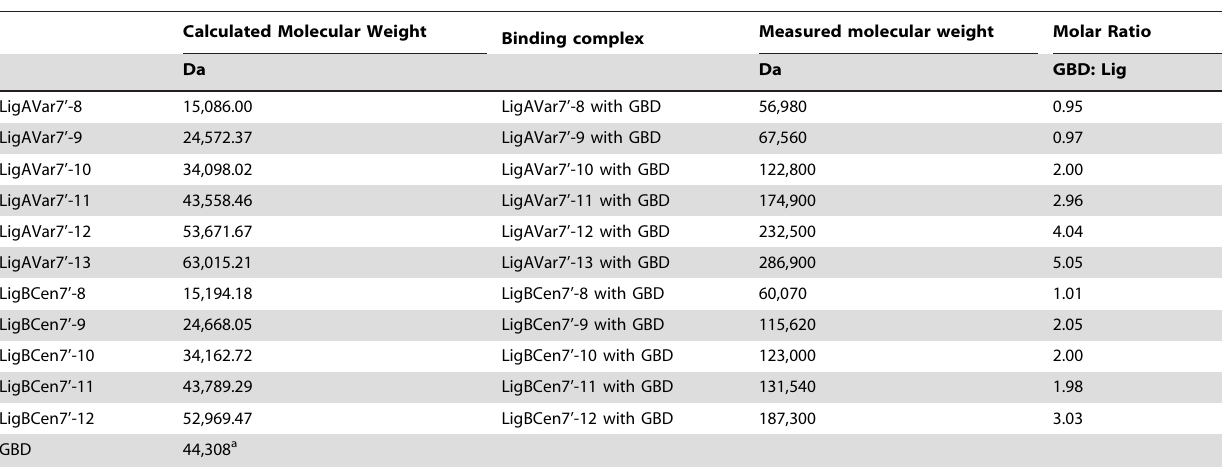
Table 4. Summary of Molar Ratio determined by SECMALLS.